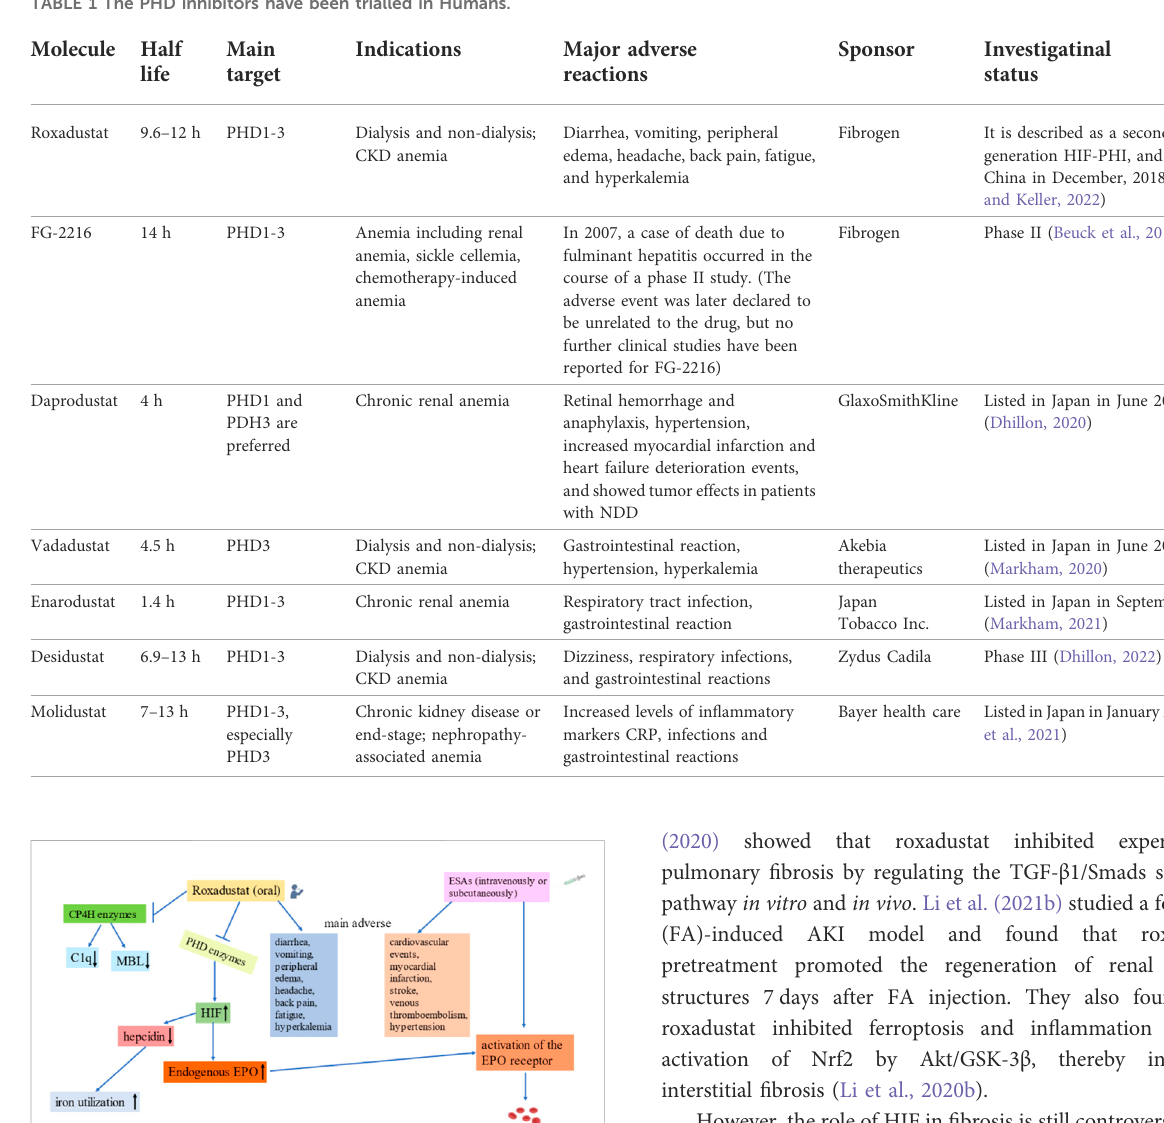
FIGURE 2 Comparison of roxadustat and erythropoietin stimulating agents. Far-left: Possible off-target effects of roxadustat. Left: Roxadustat promotes endogenous EPO production, increases EPO receptor activity, reduces the hepcidin level, and increases iron utilization. Middle-Left: Common adverse effects of roxadustat. Middle-Right: Common adverse effects of ESAs. Far- Right: Effects of erythropoietin stimulating agents on